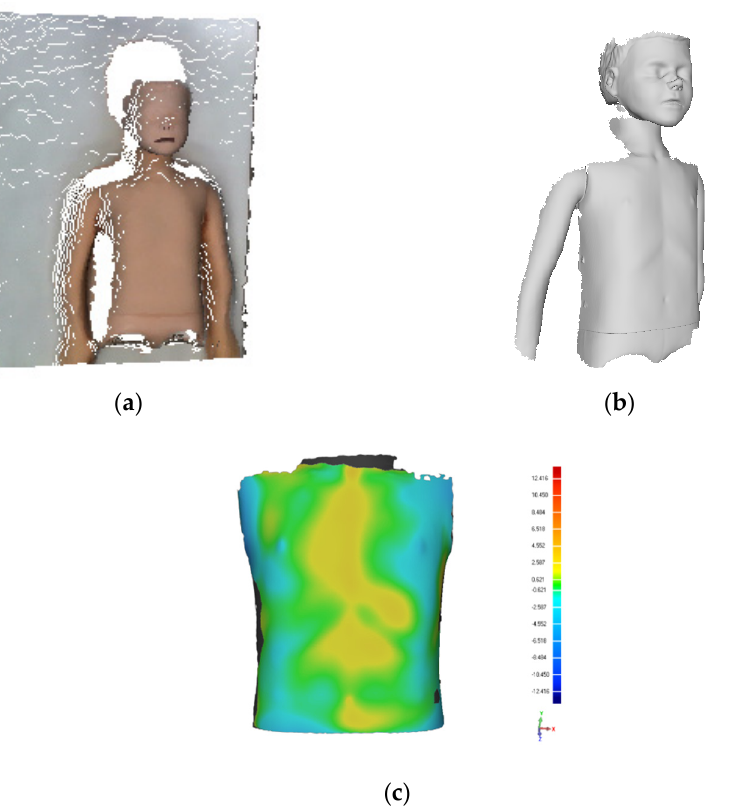
Figure 3. Accuracy tests when reproducing human anatomies: ( a ) scan performed with the Intel D415; ( b ) reference scan performed with the Artec Eva; ( c ) deviation between the two